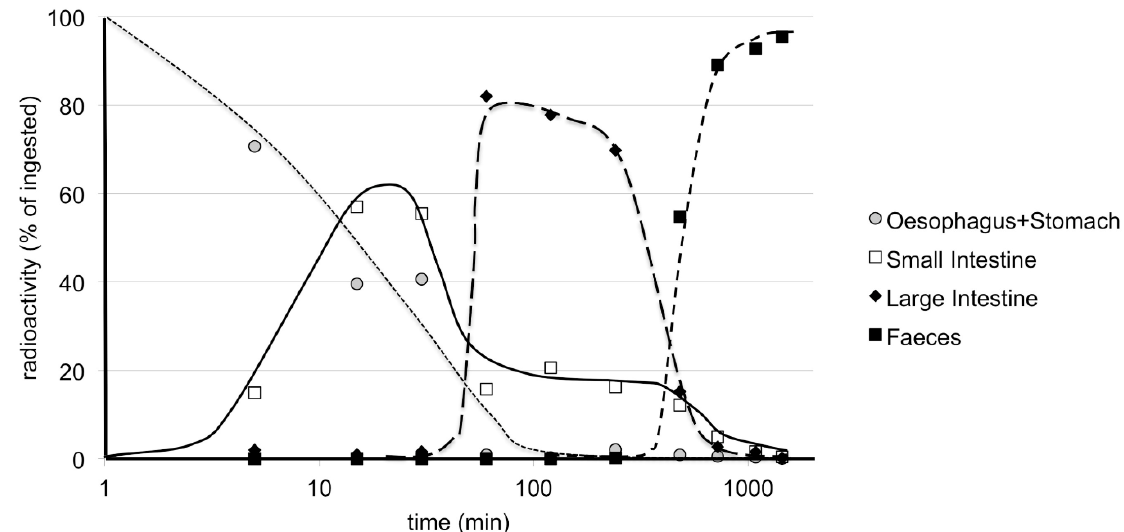
Figure 7. Time-course of the distribution of radioactivity in the stomach/intestine/feces in mice after the oral application of [1 α ,2 α - 3 H 2 ]20E. Note the logarithmic scale for abscissa. Each value is a mean of 2 animals. Note the plateau of small intestine content that is best explained by an entero-hepatic cycle and consistent with the prolonged concentration of radioactivity in bile as observed by Wu et al. [124] (reproduced, with permission, from [127]). Table 3. The effect of 3 H- Achyranthes bidentata ecdysterone on the quantitative distribution of different tissues in different tracking phases of mice (mean, n = 5) expressed in µ g g − 1 (translated from Wu et al.